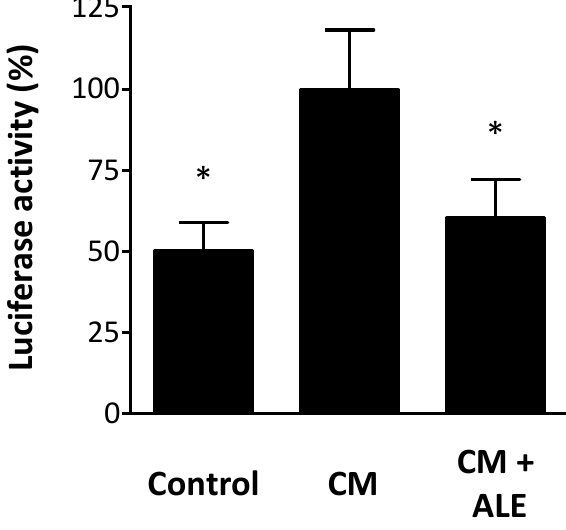
Figure 4. Artichoke leaf extracts reduce iNOS promoter activity. Human alveolar epithelium-like A549/8 cells were stably transfected with a construct containing a 16 kb fragment of the human iNOS promoter cloned in front of a luciferase reporter gene. The cells were treated with the cytokine mixture (CM) or CM in combination with an artichoke leaf extract (ALE, 10 µg/mL) for 6 h. Then, the cells were lysed, and luciferase activity was determined. The luciferase activity (normalized to protein content) was taken as a measure of iNOS promoter activity. * p < 0.05, compared with